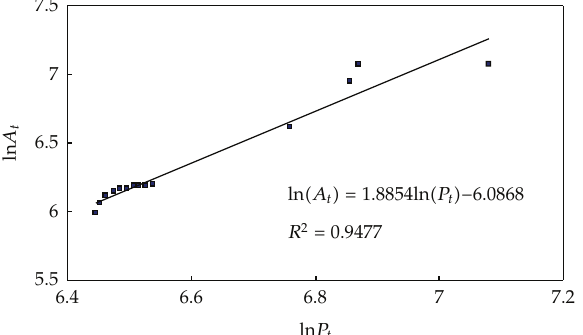
Figure 4: The allometric scaling relation between the built-up area and urban population of Beijing (cid:3) 1991– 2004 (cid:4)